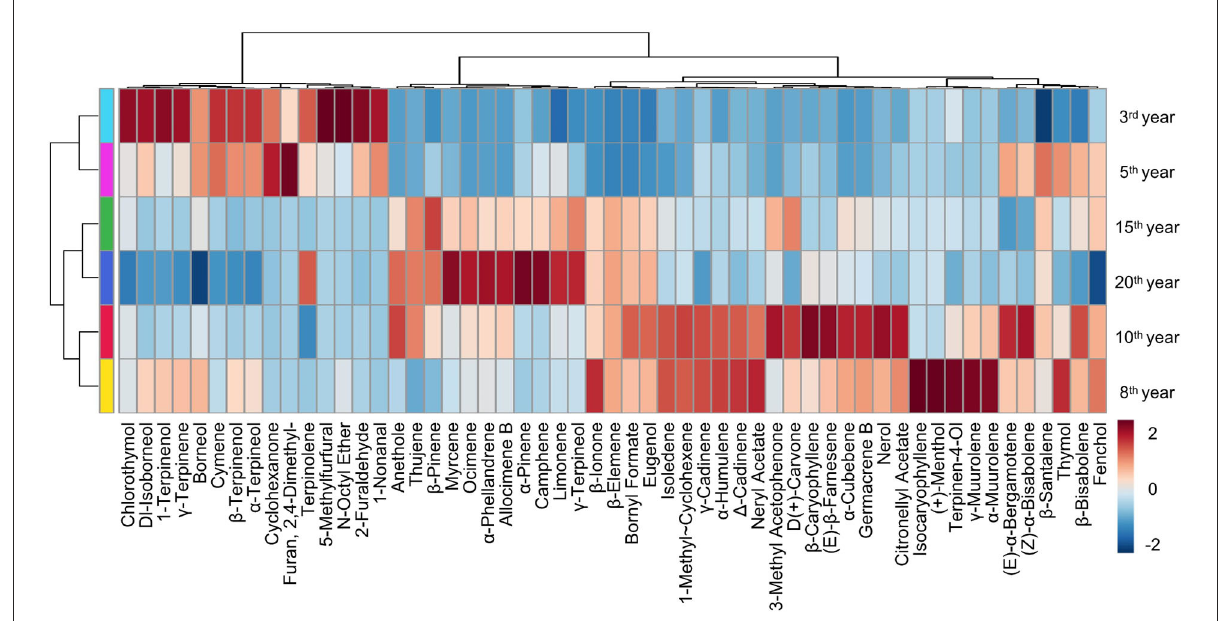
FIGURE4 HCA of Laoxianghuang based on the normalized quantities of the identified